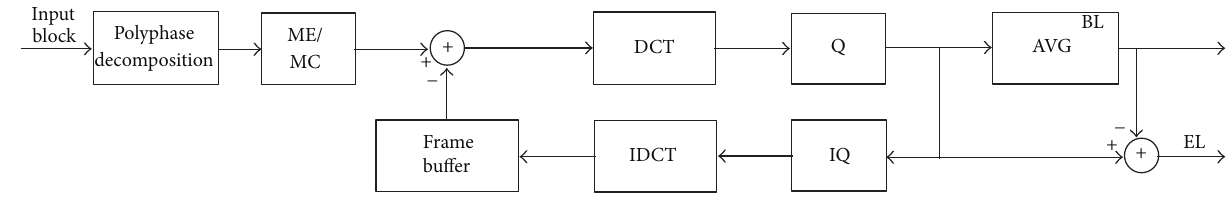
Figure 5: Block diagram of the proposed